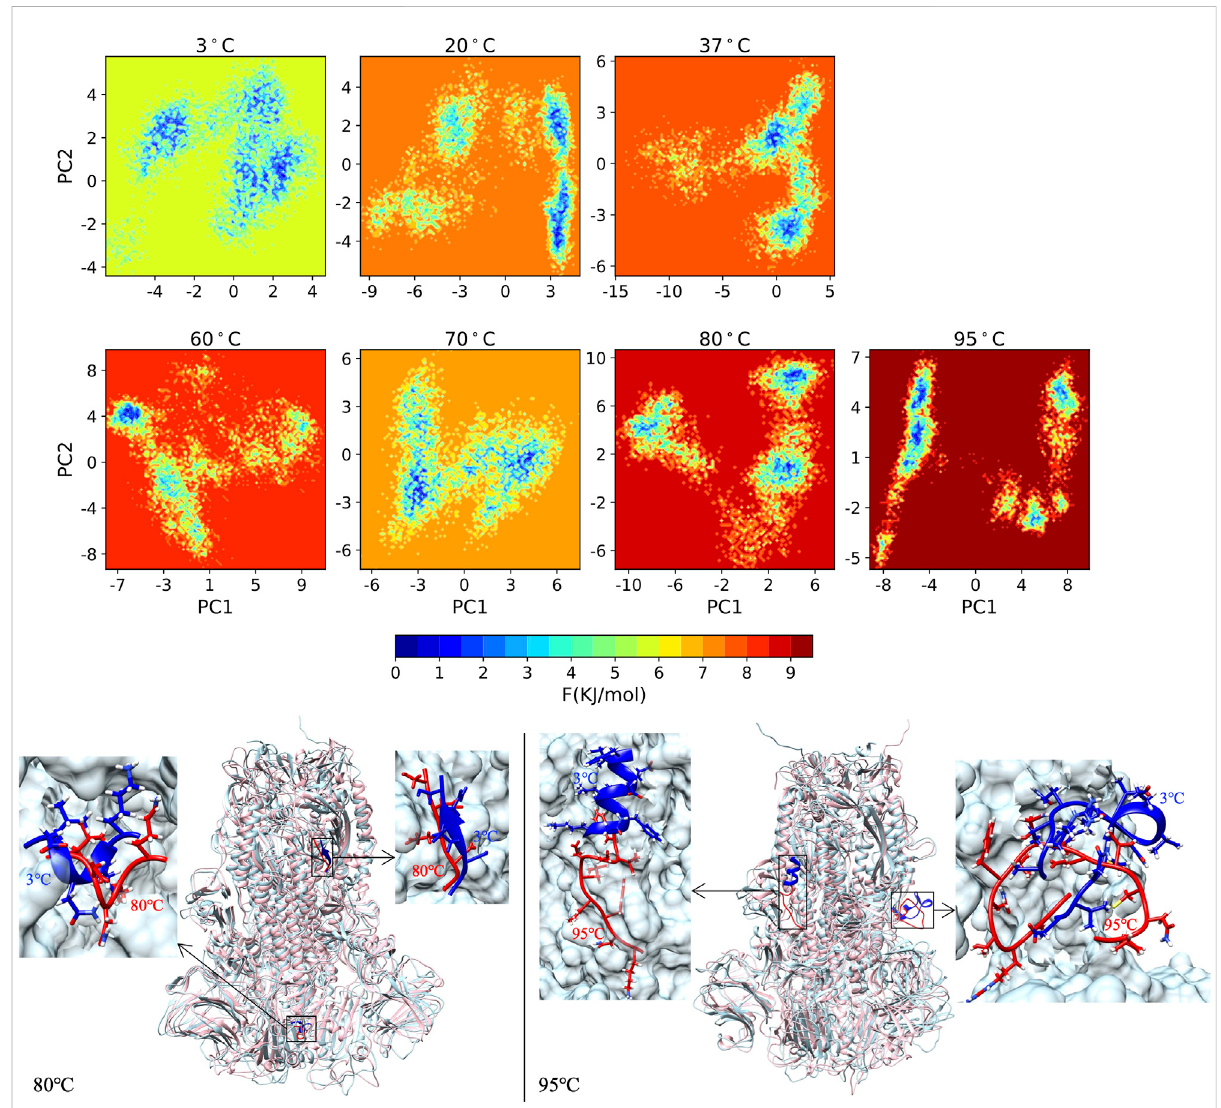
FIGURE 6 The FEL of S-protein from 3 ° C to 95 ° C with same color scale, and the protein structure for minimum energy area at 80 ° C (left) and 95 ° C (right) compared with the 3 ° C (blue) structure with zoomed unfolding